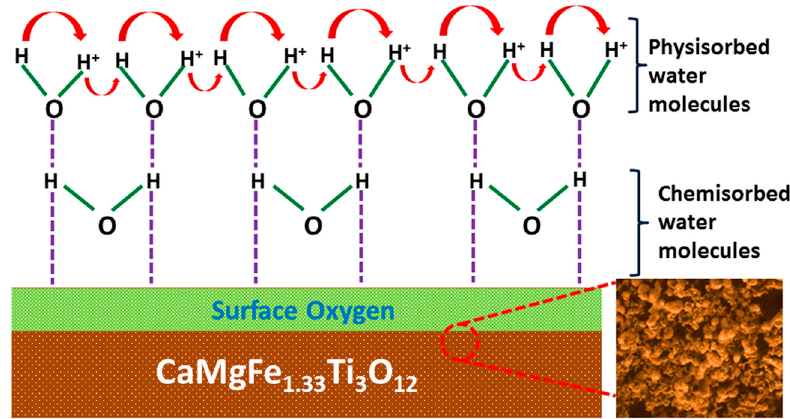
Figure 8. Schematic representation of the humidity sensing mechanism of CMFTO electro-ceramic at different humidity environment. Note: the adsorption of water molecules on CMFTO nanoceramic is characterized by two processes. The first-layer water molecules (at lower humidity) are attached on the CMFTO electro-ceramic through two hydrogen bonds. As a result, the water molecules are not able to move freely and thus, the impedance value increases. In contrast, from the second layer (at higher humidity), water molecules are adsorbed only through one hydrogen bond. Hence, the water molecules are able to move freely and thus, the impedance value decreases. This insists to increase the capacitance value.